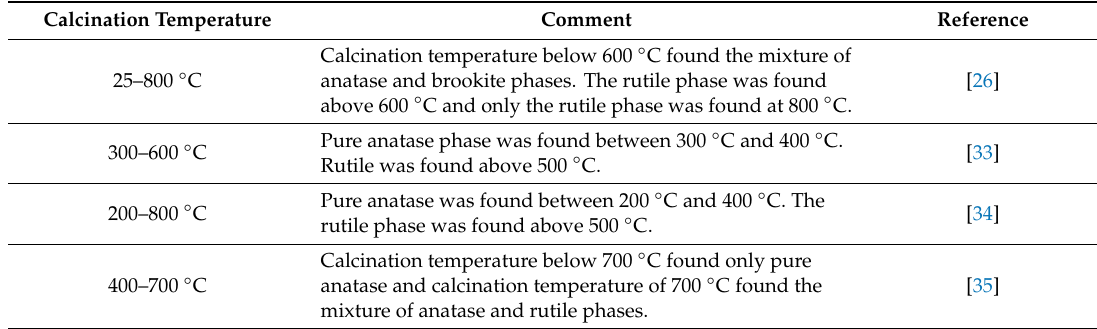
Figure 4. ( a ) Relationship between calcination temperature before and after calcination temperatures from 300 °C to 800 °C and percentage of phase content of synthesized TiO 2 , ( b ) diffuse reflectance spectroscopy (DRS) spectra of TiO 2 with different calcination temperatures. Table 2. Phase transition of TiO 2 synthesized via sol-gel method and calcined with different calcination temperatures.